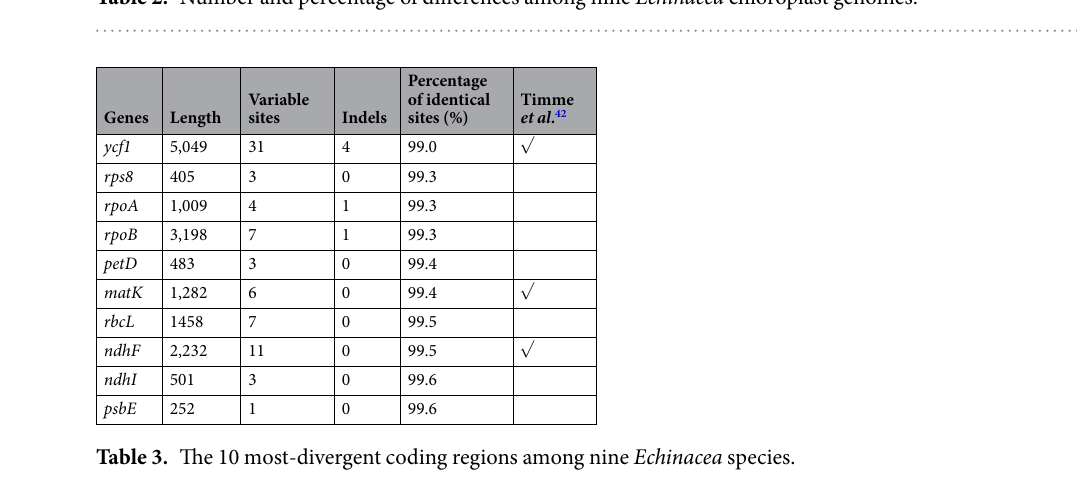
Table 2. Number and percentage of differences among nine Echinacea chloroplast genomes.